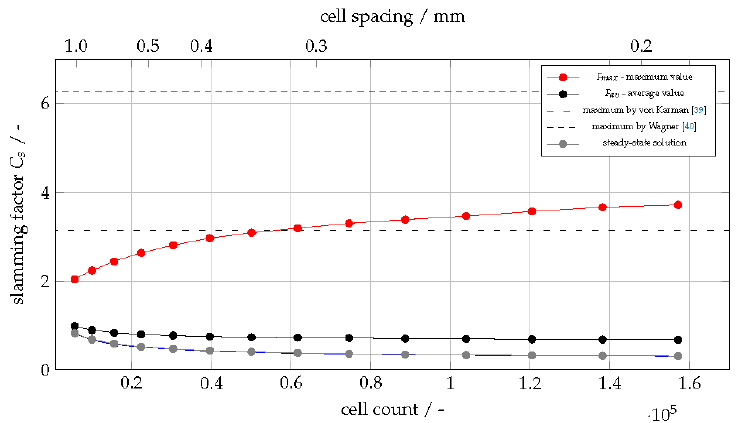
Figure 8. Mesh study of the slamming factor in comparison with the models by von Karman [39] and Wagner [40]. Here, U in = 20 ms − 1